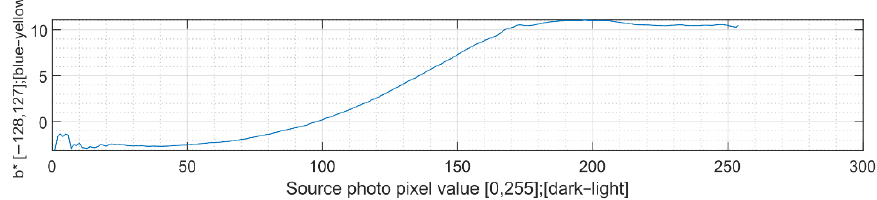
Figure 10. CIELAB b* characteristic of wood-engraved picture.